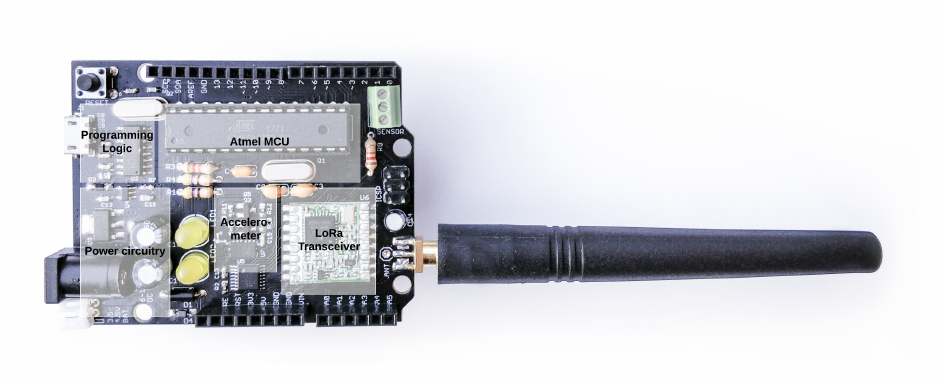
Figure 2. Picture of the proposed solution, including dipole